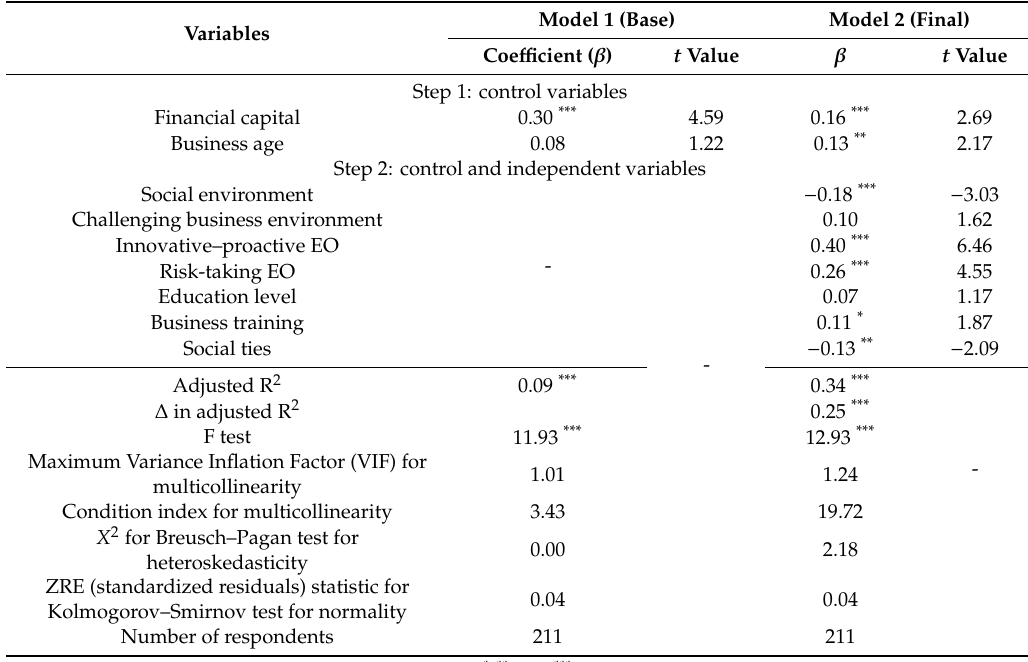
Table 4. Results of hierarchical multiple regression models a